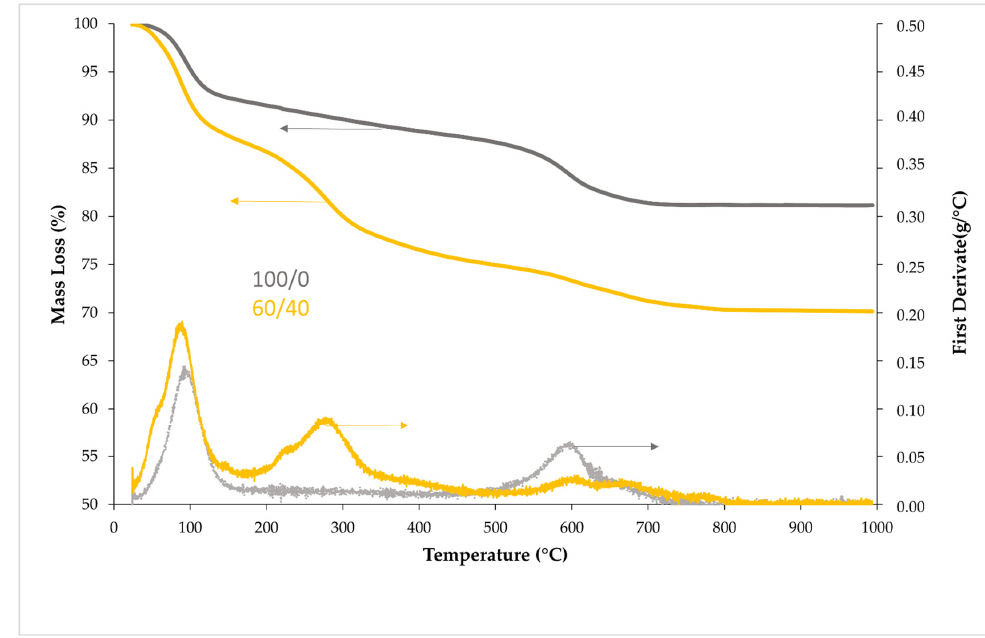
Figure 3. Thermogravimetric results.